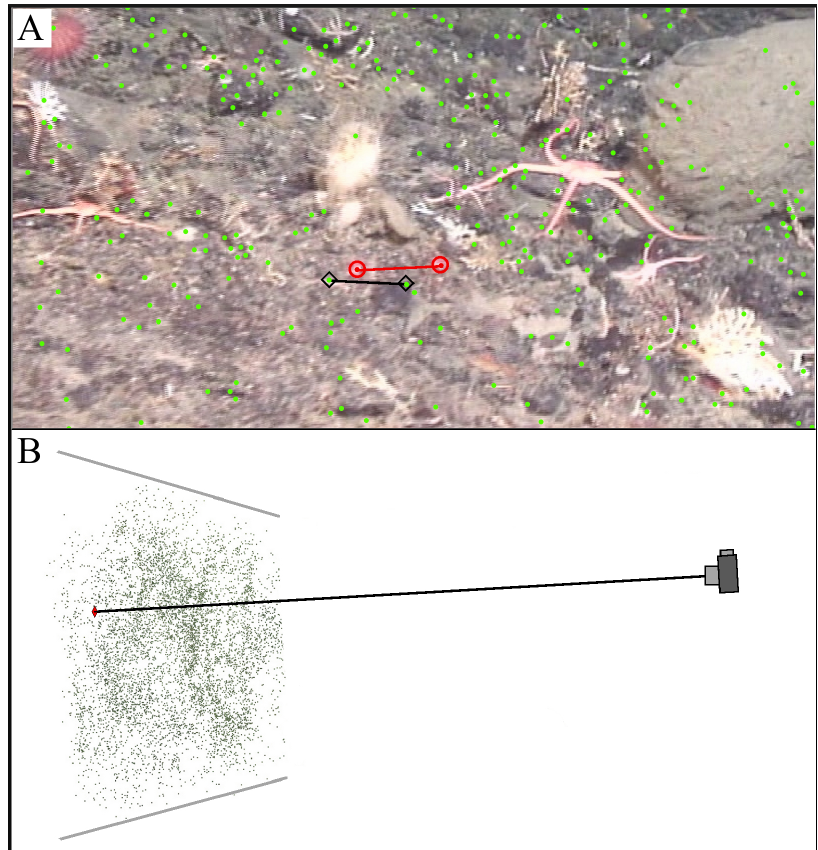
Fig. 5. Scaling of the 3-D models (A) . Dive A and B (Antarctic): the distance between the laser points (5cm, red line) is used to calculate the distance between the two nearest SmartPoints (4.6cm, black line). (B) Dive C (Chile): the distance (1.9m, black line) measured by the echo sounder between the camera and the central point (red dot) in the first frame (not represented here) is employed as scaling reference for the 3-D model (green dots, grey lines for perspective). Table 2. Subtransects lengths computed from the 3-D models for the three dives. Dive Number of Calibration Type of Total Mean subtransects error (%) length length (m) length